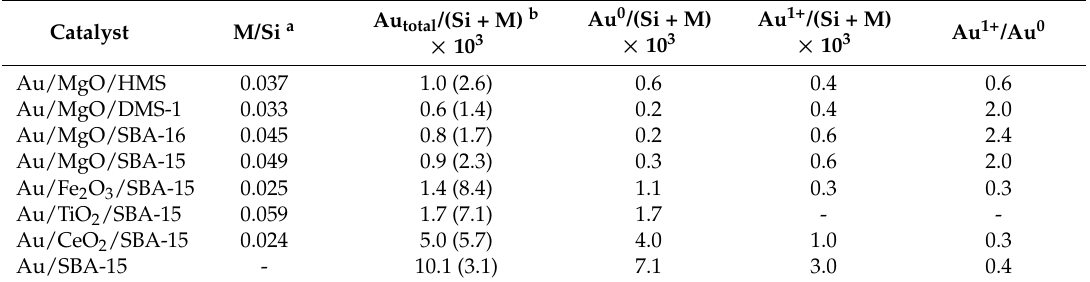
Table 4. Surface atomic ratios of the dried Au catalysts (from